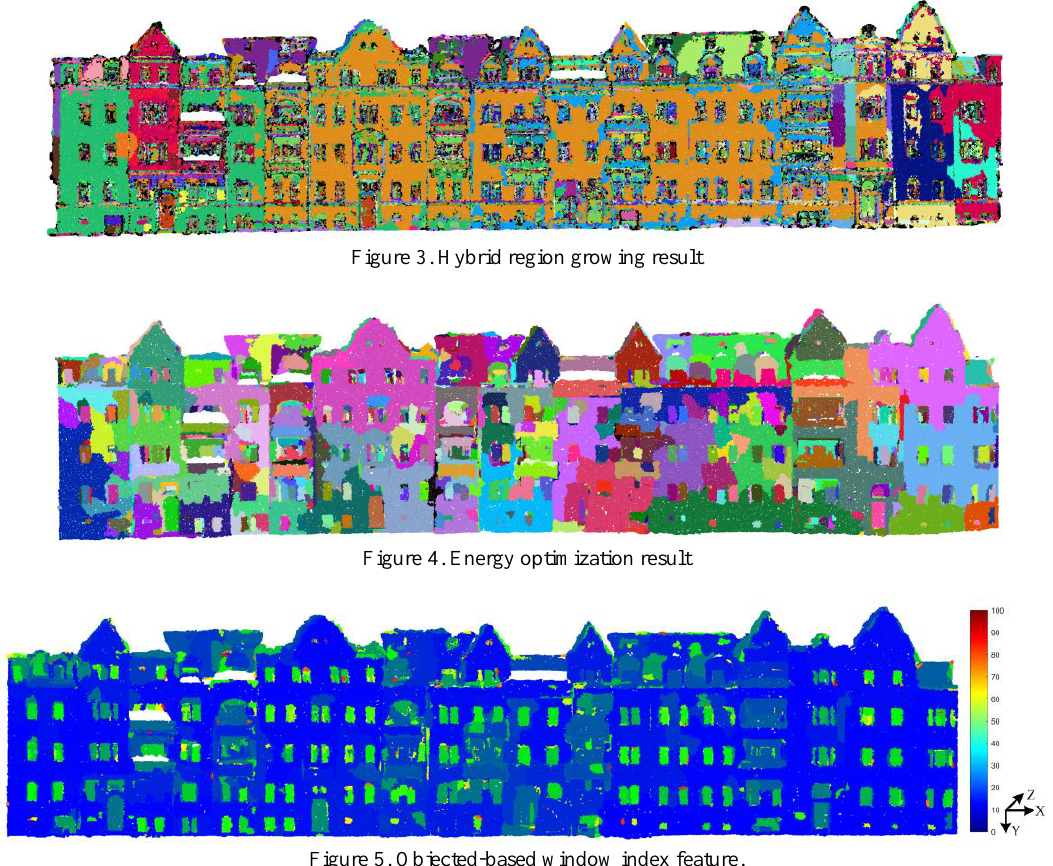
Figure 5. Objected-based window index